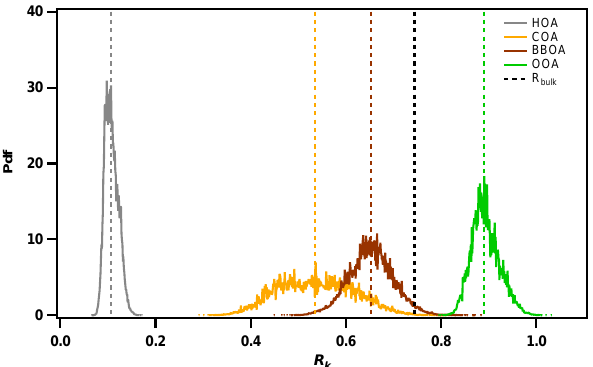
Figure 10. Recoveries R k for HOA, COA, BBOA, and OOA (OOA1 + OOA2) obtained from the intercomparison of source ap- portionment results of offline AMS to online ACSM data (Zurich 2011–2012). 100000 random combinations of offline and online solutions and randomly chosen offline repeats result in the same amount of time-independent R k , which are expressed as probability density functions